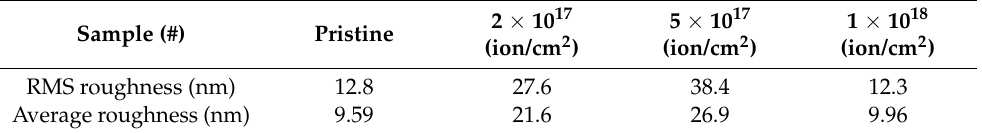
Figure 4. Three-dimensional AFM images of the samples: ( a ) Un-implanted; ( b ) implanted, dose 2 × 10 17 ions/cm 2 ; ( c ) implanted, dose 5 × 10 17 ions/cm 2 ; ( d ) implanted, dose 1 × 10 18 ions/cm 2 . Table 2. Roughness information.